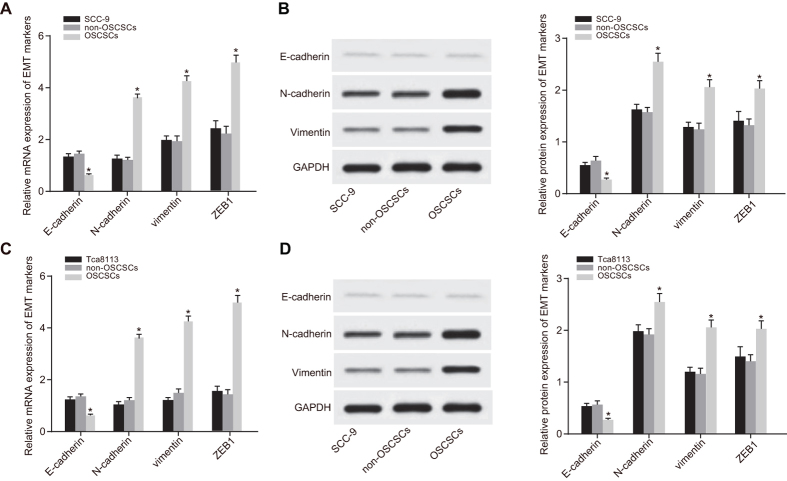
The mRNA and protein expression of E-cadherin, N-cadherin, vimentin and ZEB1 in OSCSCs.(A,B) The mRNA and protein expression of E-cadherin, N-cadherin, vimentin and ZEB1 in SCC-9 cells, non-OSCSCs and SCC-9 OSCSCs detected by qRT-PCR and Western blotting, respectively. C and D, The mRNA and protein expression of E-cadherin, N-cadherin, vimentin and ZEB1 in Tca8113 cells, non-OSCSCs and Tca8113 OSCSCs detected by qRT-PCR and Western blotting, respectively. In A and B, *represents P < 0.05 comparisons with SCC-9 cells and non-OSCSC cells. In C and D, *represents P < 0.05 comparisons with Tca8113 cells and non-OSCSCs. OSCSCs, oral squamous carcinoma stem cells; ZEB1, zinc finger e-box binding homeobox 1; qRT-PCR, quantitative real-time polymerase chain reaction.